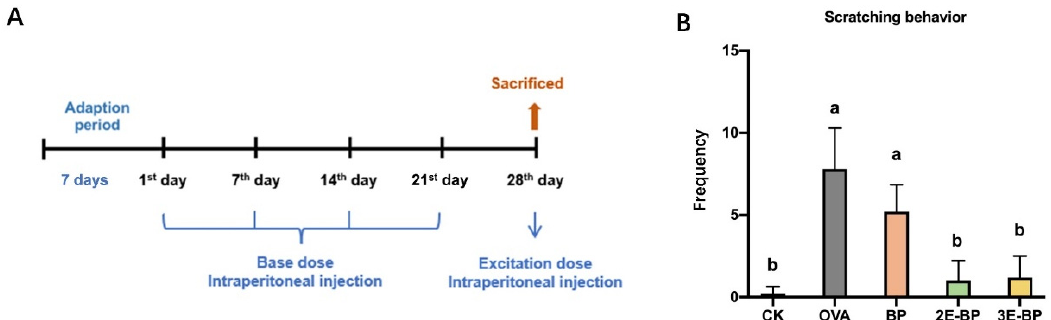
Figure 1. BALB/c mice administration schedule. ( A ) Scratching frequency of mice in different treatment groups. ( B ) Different letters indicate a significant difference among different groups ( p <